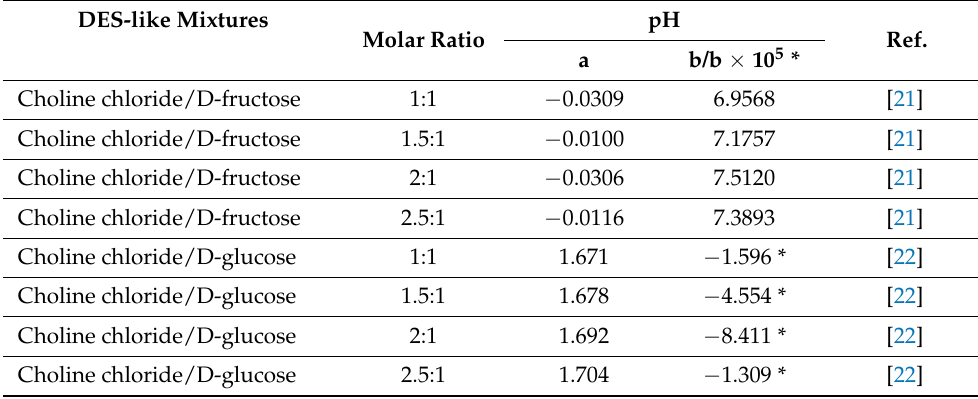
Choline chloride/D-glucose